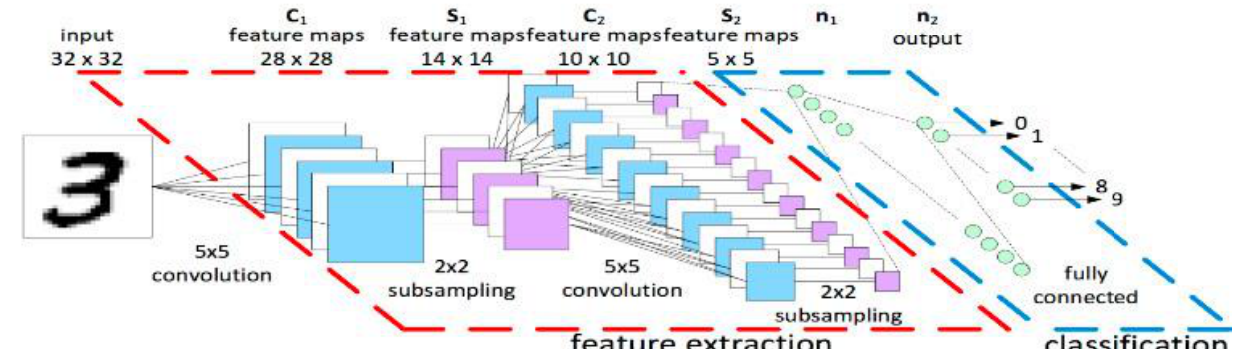
Figure 4 Structure of Convolutional Neural Networks (Sharma et al. 2018)